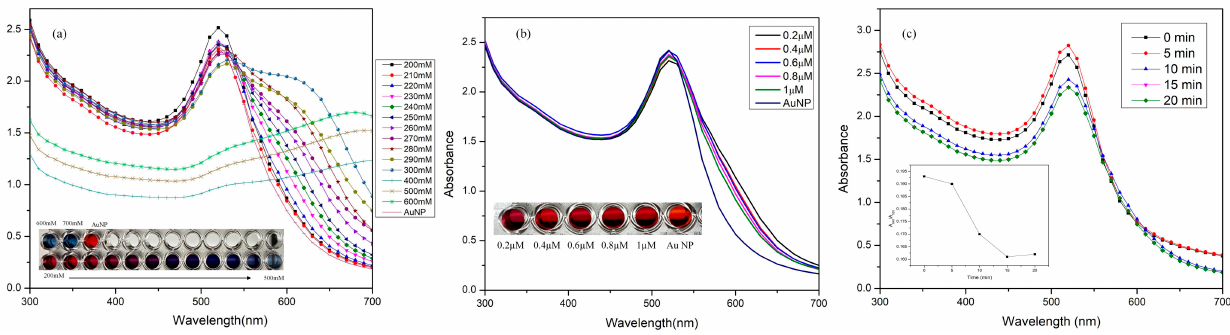
Figure 4. Optimization of: ( a ) NaCl concentration varied from 200 mM to 600 mM. Inset: the 96-well plate experiment depicting the extent of AuNP agglomeration and color gradation from deep red to purple to blue. ( b ) Aptamer concentration varied from 0.2–1 µM against 280 mM NaCl. ( c ) Interaction time between the aptamer-coated AuNP incubated for various lengths time and (inset) A640/A520 absorbance ratio vs incubation time.